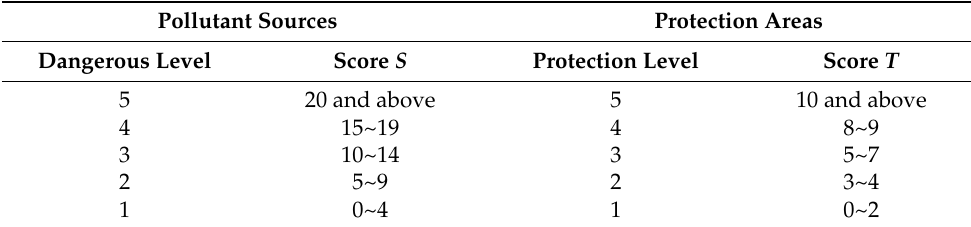
Table 3. Classification criteria of dangerous level and protection level.